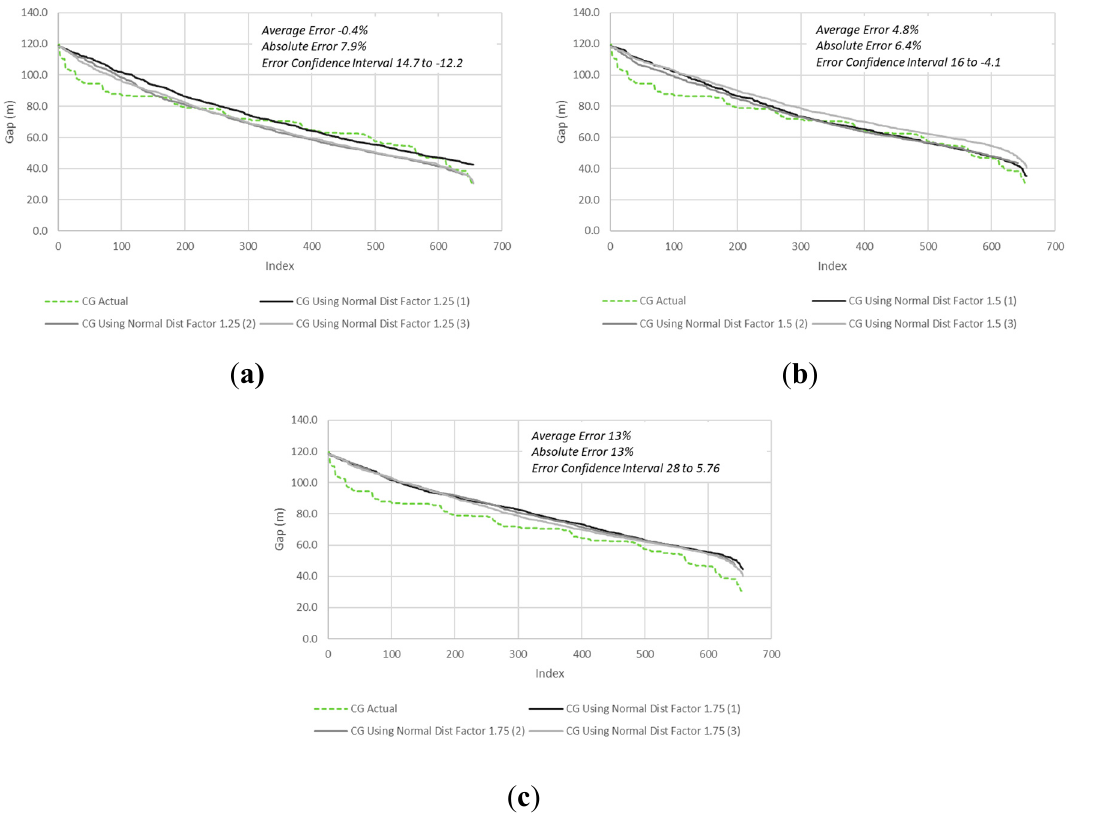
Figure 4. Comparison between actual data and enhanced simulation results. ( a ) Applying positive factor of 1.25; ( b ) applying positive factor of 1.5; ( c ) applying positive factor of 1.75. 3.2. Gender